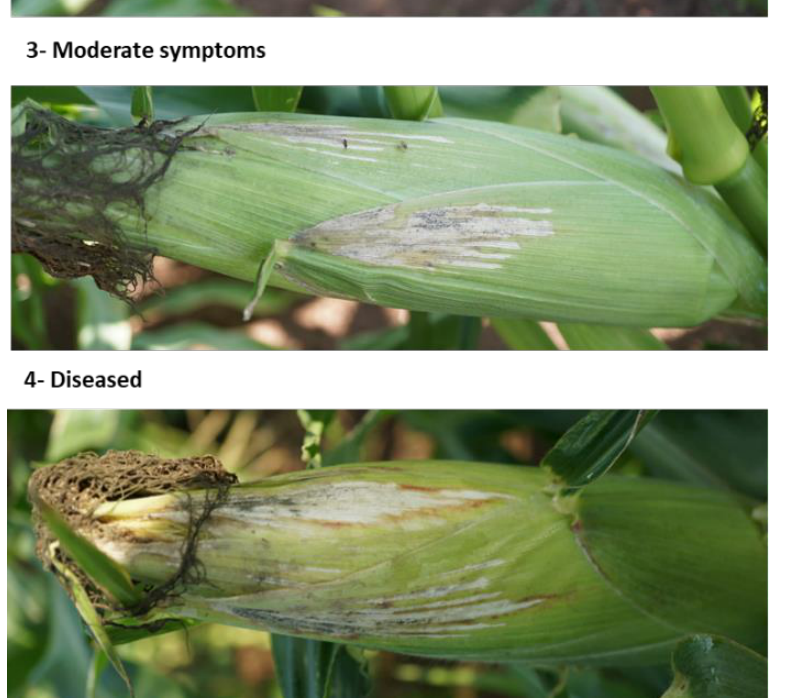
Figure 5. Classification of the cobs’ spathes disease symptoms at the end of the 2020 field experiment (82 DAS). Representative images are in increasing degrees of late wilt symptoms. The dehydration symptoms on the large bracts surrounding the cobs (the spathes) were estimated according to the following scale: 1—healthy with no signs of dehydration, 2—minor symptoms up to 20% of the cob surface, 3—moderate symptoms that cover 30–40% of the cob surface, 4—diseased with 50% or more dehydrated cobs’ area.